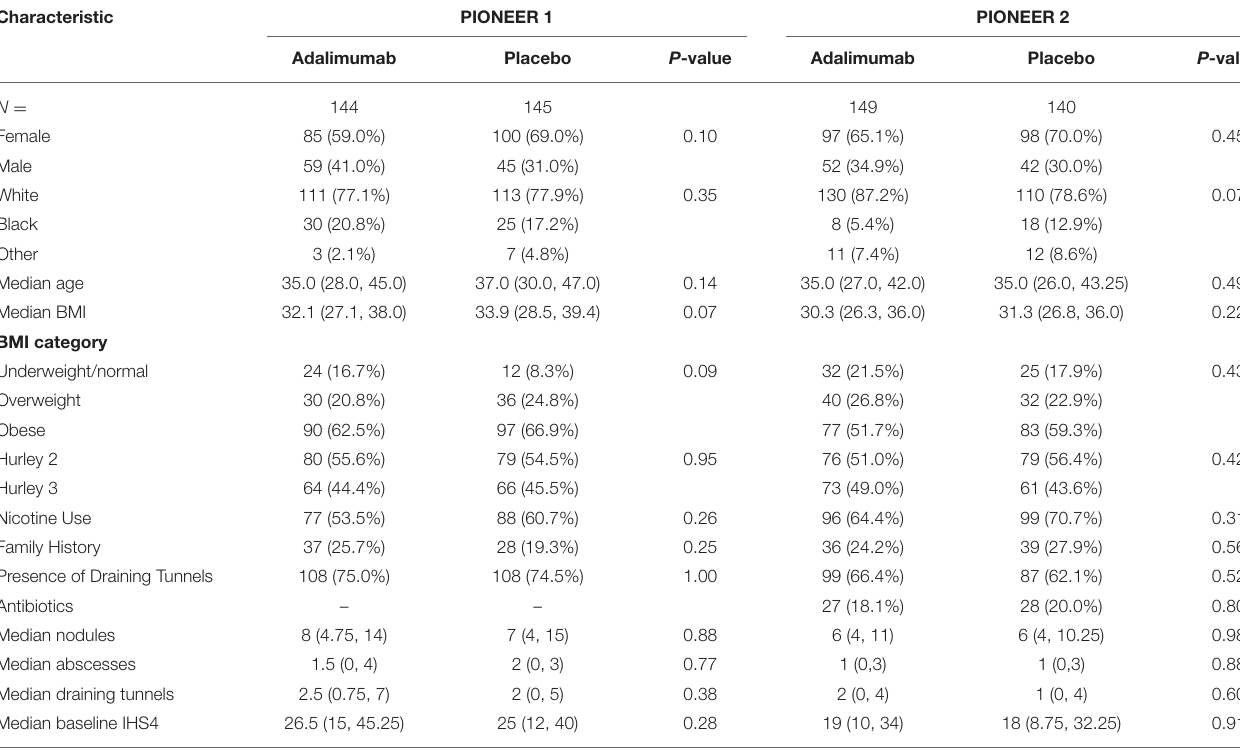
TABLE 1 | Characteristics of population in each of the trial data.